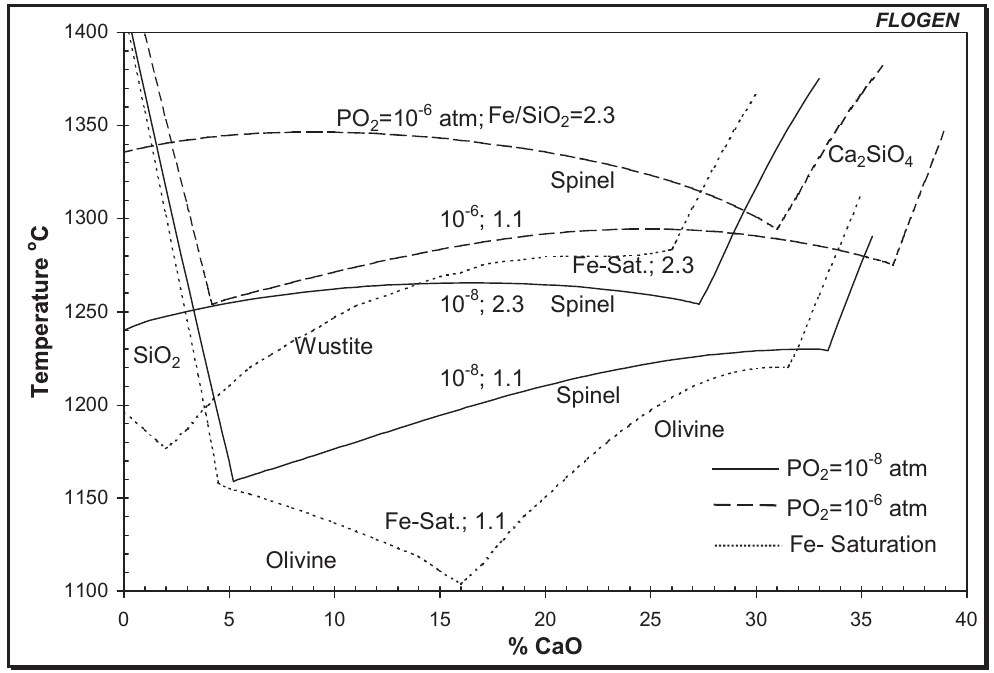
Figure 4. Liquidus surface of fayalite (“F”) and ferrous calcium silicate slag (“FCS”) slag at log ŒP O to conditions of copper converting [10–16].